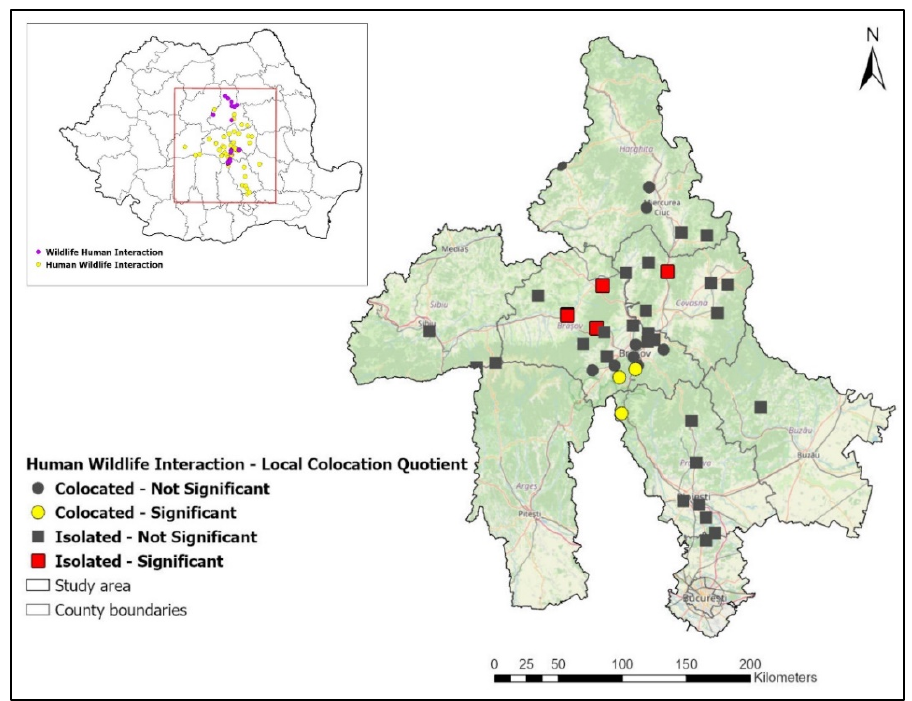
Figure 3. Map of LCLQ results for HWI/WHI pair. The p -value index was represented as significant label for p -value < 0.05 and not significant label for p -value > 0.05.